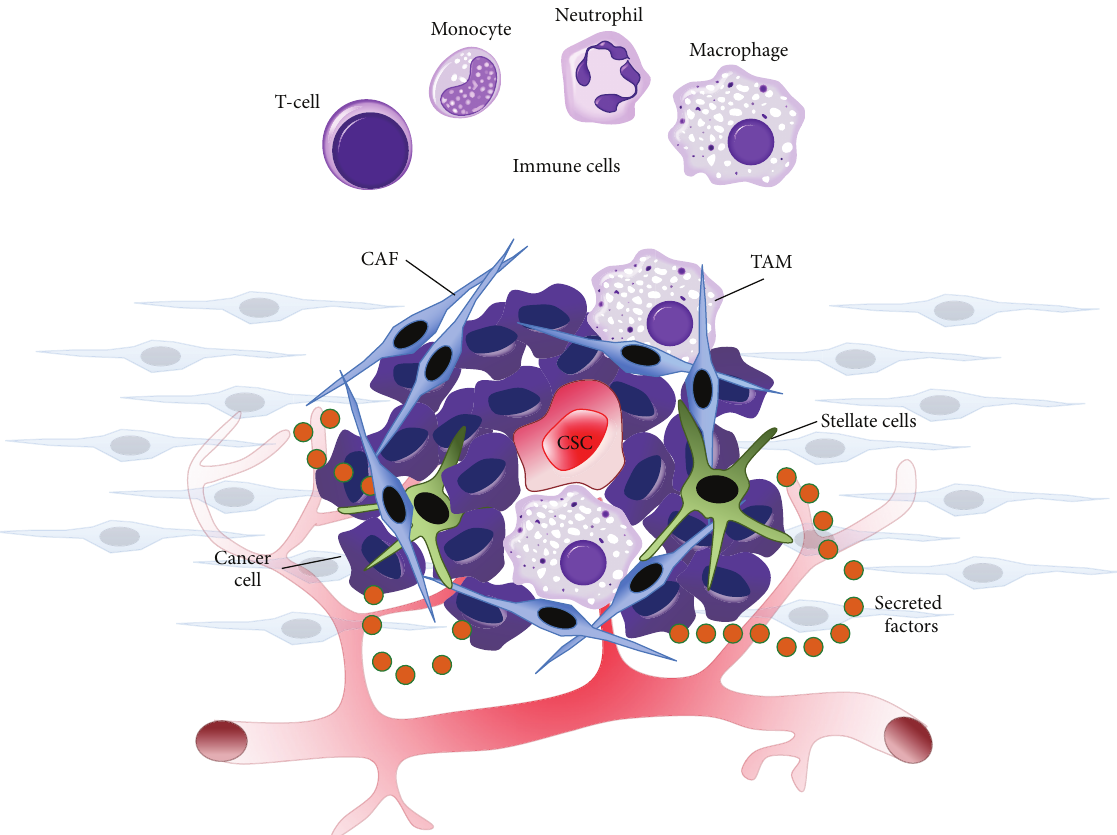
Figure 2: The CSC niche and tumor microenvironment. At center stage is the CSC, in contact with a complex and dynamic cellular network, including daughter cancer cells, stellate cells (in the case of HCC and PDAC), cancer-associated fibroblasts (CAFs), and immune cells, which include T-cells, monocytes, neutrophils, and tumor-associated macrophages (TAMs). Nourished by the circulatory system, these cells communicate with one another and directly with the CSC via secreted factors, forming a positive feedback loop that promotes CSC tumorigenicity and